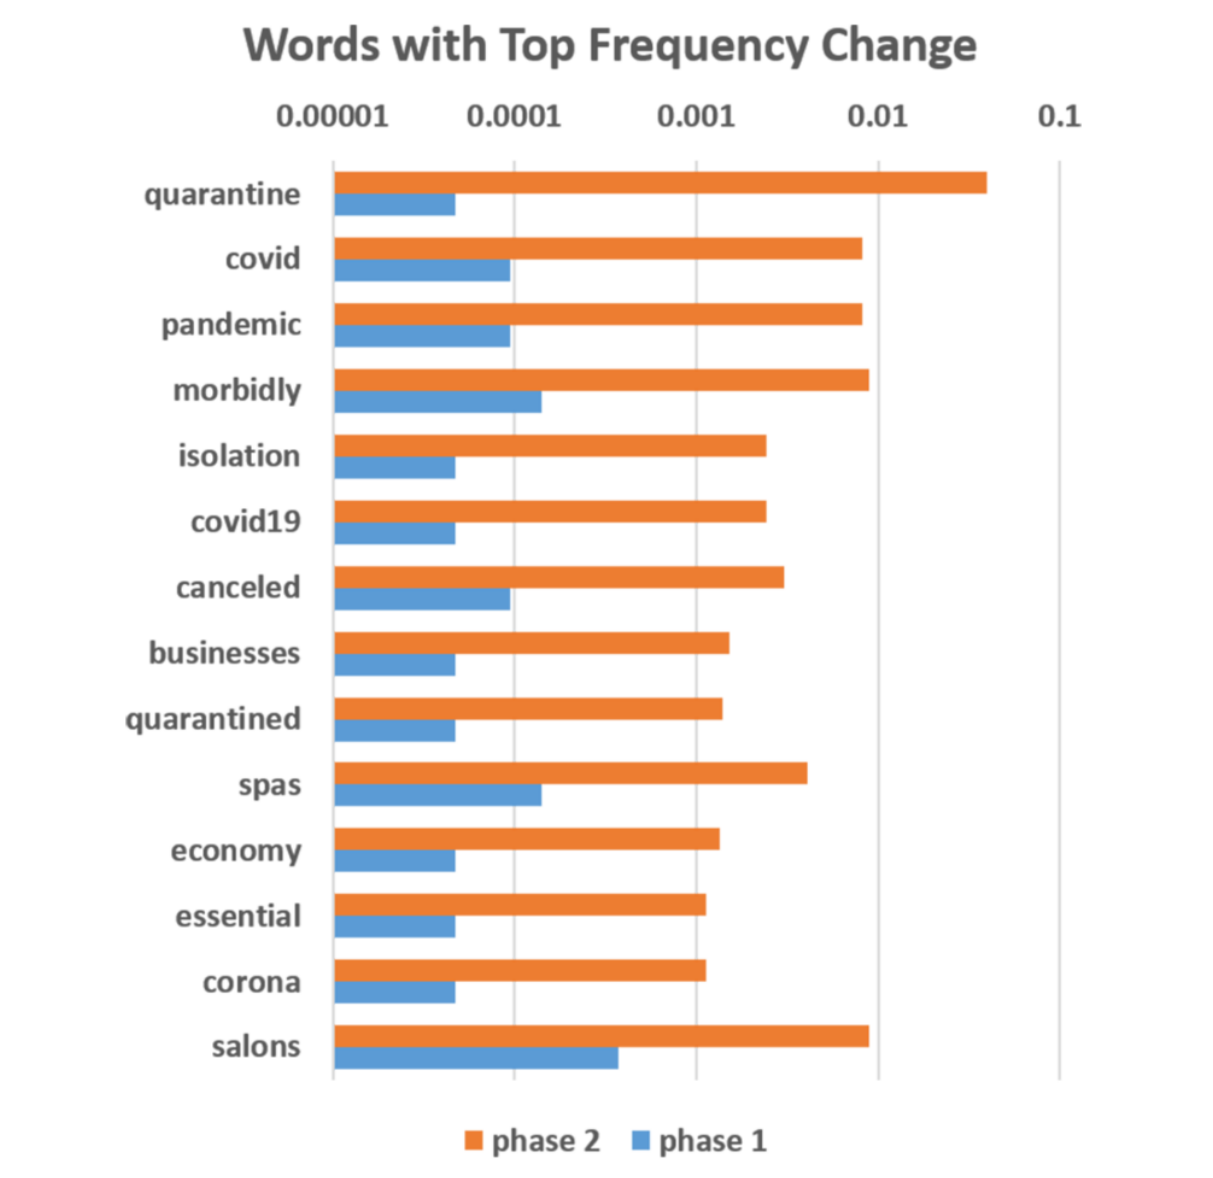
Figure 5. Frequencies of words with the greatest frequency